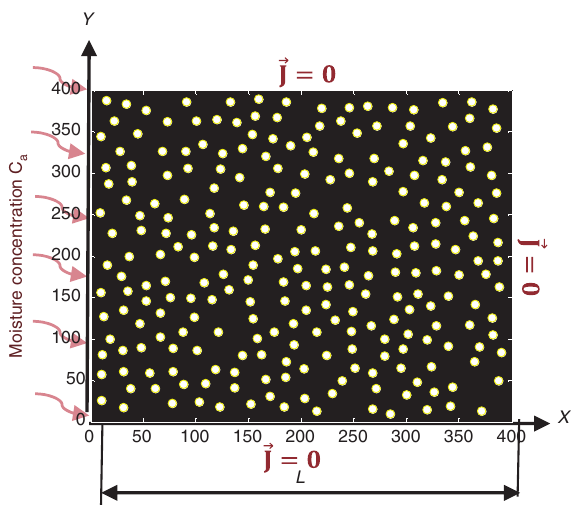
Figure 15: Representation of moisture diffusion through